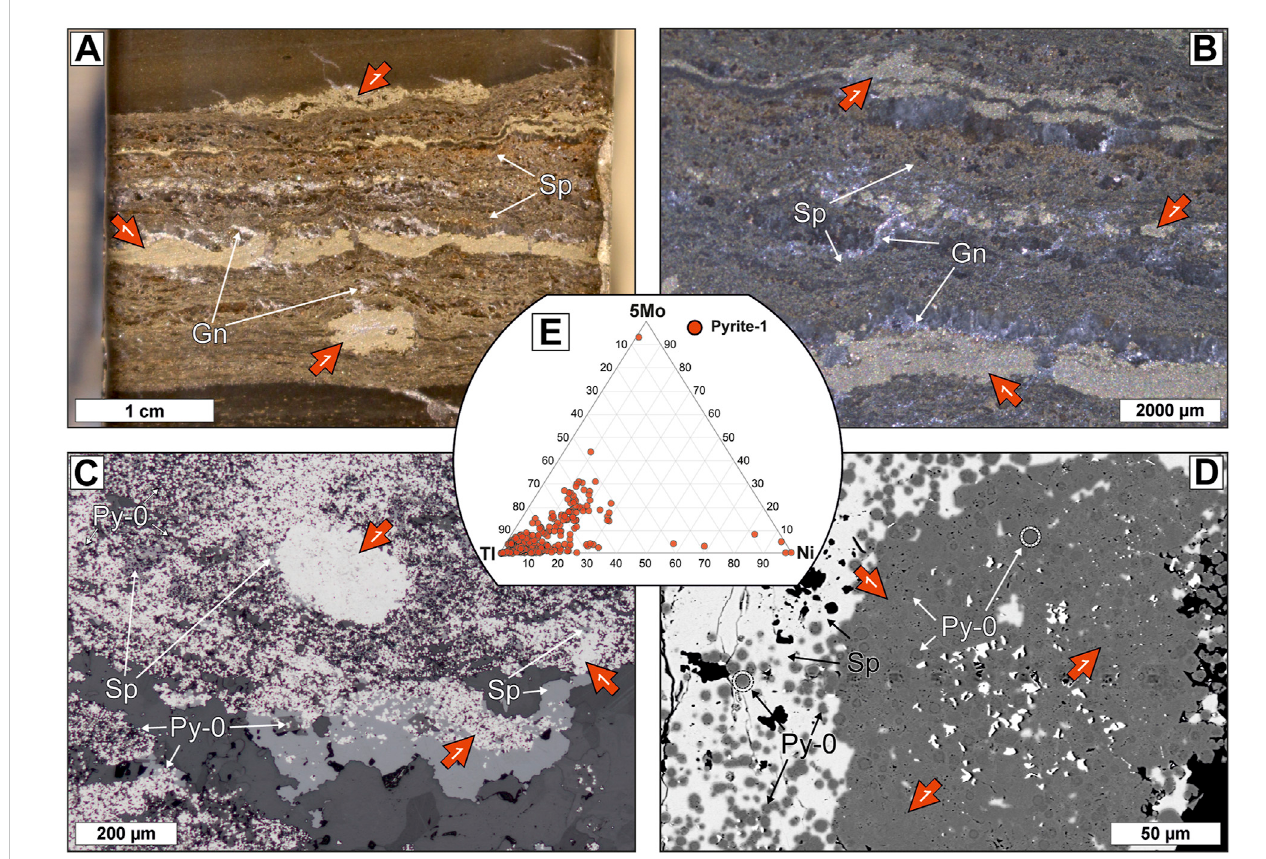
FIGURE 5 Ore stage 1 massive sul fi de samples from the George Fisher deposit containing Py-0, anhedral Py-1 (red arrow), sphalerite (Sp), and galena (Gn). (A) A handspecimenphotographand (B) Abinocularphotomicrographoflaminatedsiltstonewithorestage1mineralization(samplePRK798C014).Pyrite-1occurs in nodules and nodular beds, sphalerite is stratabound in the laminated siltstone and galena occurs in small veinlets that cut across strata. (C) A re fl ected light photomicrograph of sample PRK798C014 with individual grains and grain aggregates of Py-0. Pyrite-1 and sphalerite overgrow Py-0. (D) A